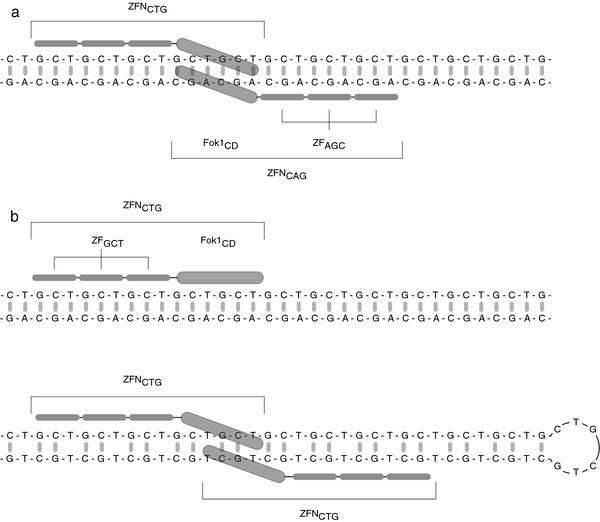
Predicted modes of ZFN binding. (a) Binding of a ZFNCTG and ZFNCAG heterodimer capable of cleaving heteroduplex DNA. FokI CD, FokI catalytic domain; ZFPGCT, (GCT)-recognition zinc finger protein; ZFPAGC, (AGC)-recognition zinc finger protein. (b) Predicted modes of ZFNCTG monomer binding to heteroduplex DNA (upper) or homodimeric ZFNCTG capable of cleaving (CTG) hairpin DNA (lower). (Reprinted from [7] with permission)